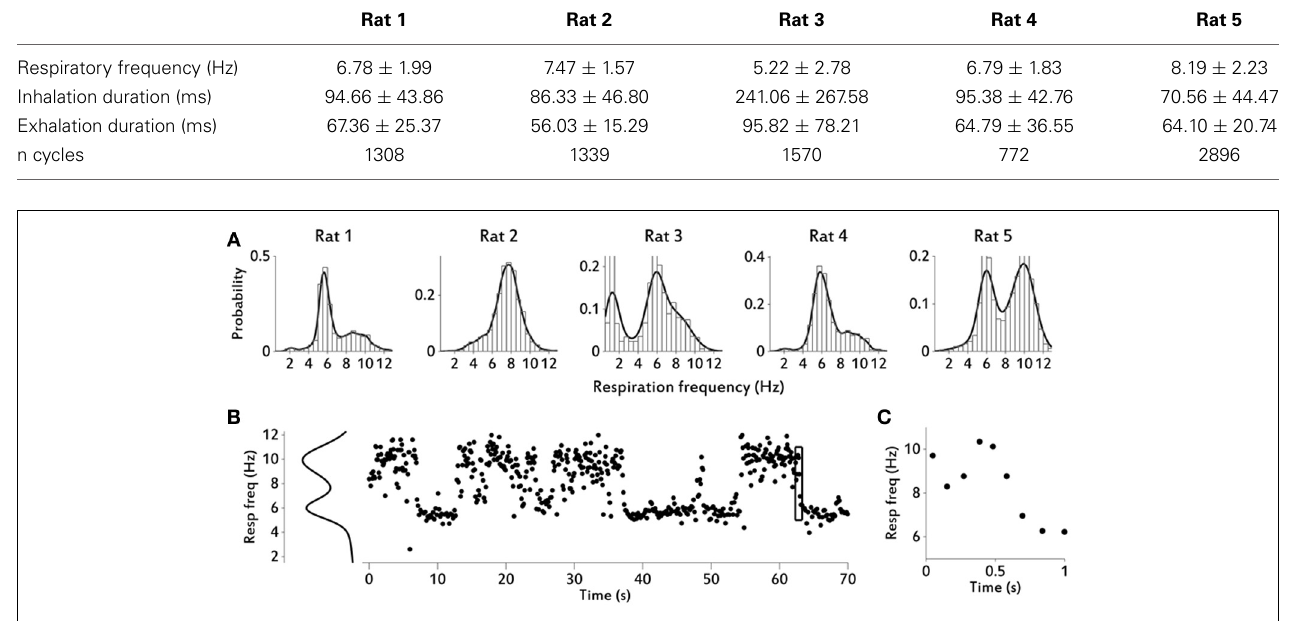
respiratory frequency over time during 70s, for rat 5. Distribution fit is shown on the left. For each respiratory cycle the time assigned corresponds to time of inhalation start. (C) Enlarged image of section marked with a rectangle in (B) , to show that changes in respiratory frequencies can occur rapidly (e.g., changes of 4–6Hz in magnitude occur in 1–2